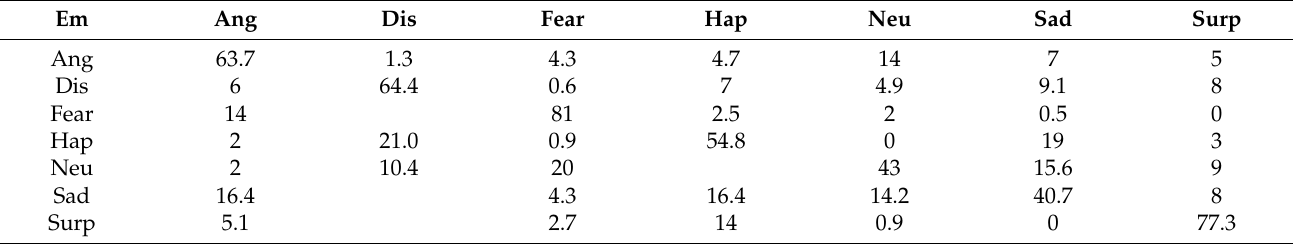
Table 5. Matrix representing the confusions in SFEW dataset.